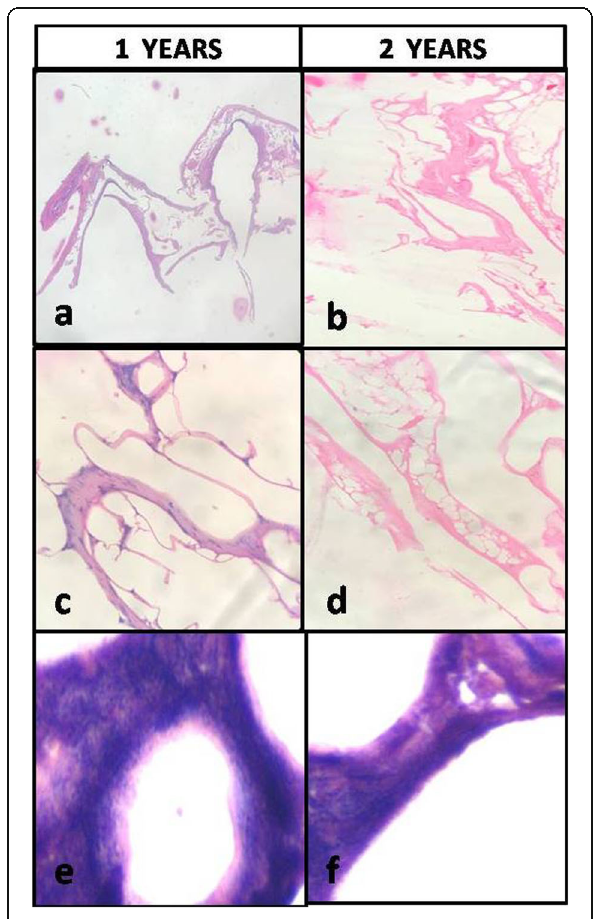
Fig. 4 Histological and microbiological assessment after 1, 3, and 6 months of extraction. a – c Increasing vacuolations of the ECM with time (× 100). d – f Degenerating nuclei of the fibroblasts (× 400). g – i Intact odontoblastic layer (× 400). j – l Gram stain (Brown and Brenn) showing the presence of Gram-positive cocci of Staphylococcus and Streptococcus species (× 1000)